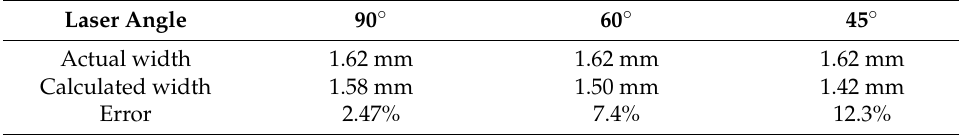
Table 2. Error analysis table under different beam projection angles.